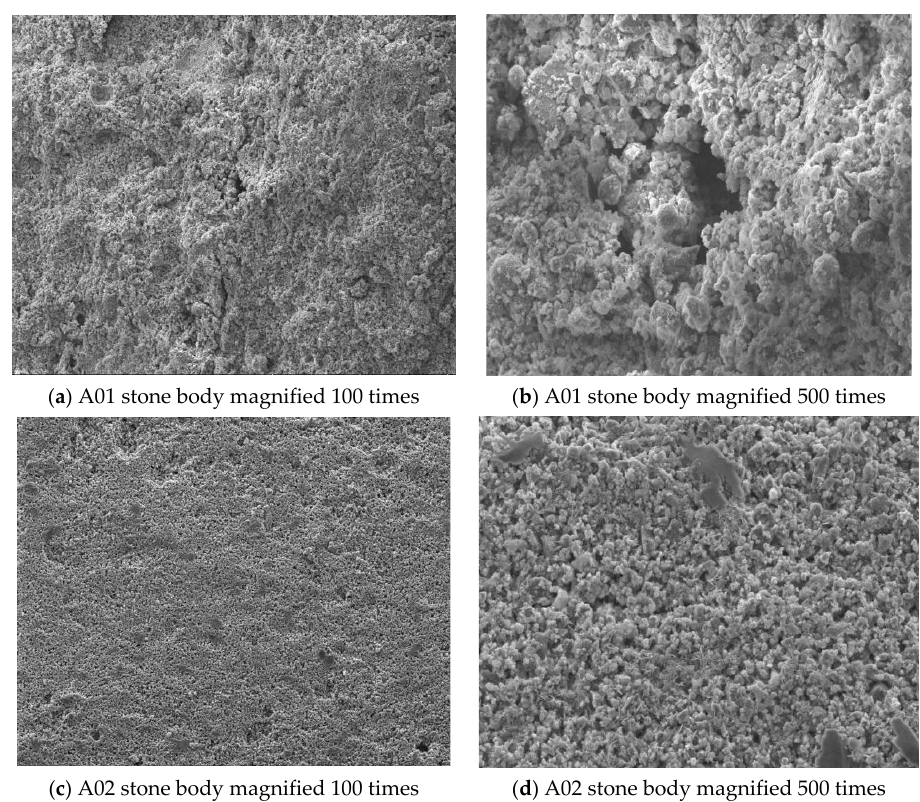
Figure 11. Scanning electron microscopy images of stone